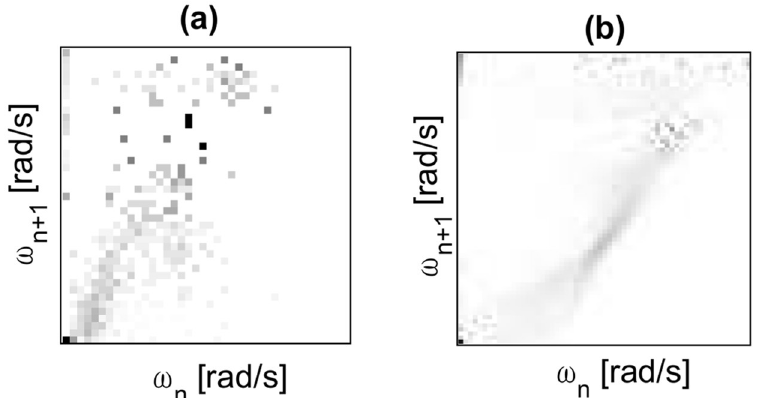
Fig 8. Transition probability matrices (TPMs) [9] obtained for (a) the experimental dataset of the motion of the RW down the slope and (b) for the simulated second data-set for Scenario I with μ ¼ N ð 0 : 45 ; 0 : 08 2 Þ , η ¼ N ð 0 : 6 ; 0 : 1 2 Þ .